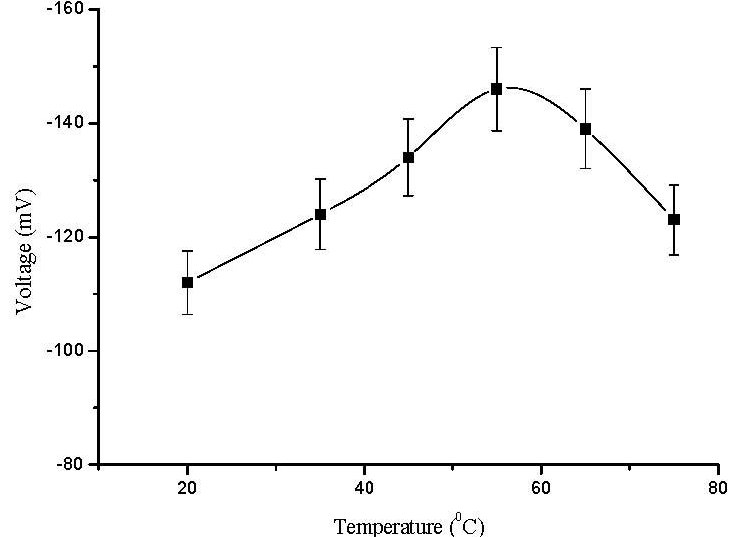
Figure 5. Calibration curves showing the investigation of EMF response with the change in